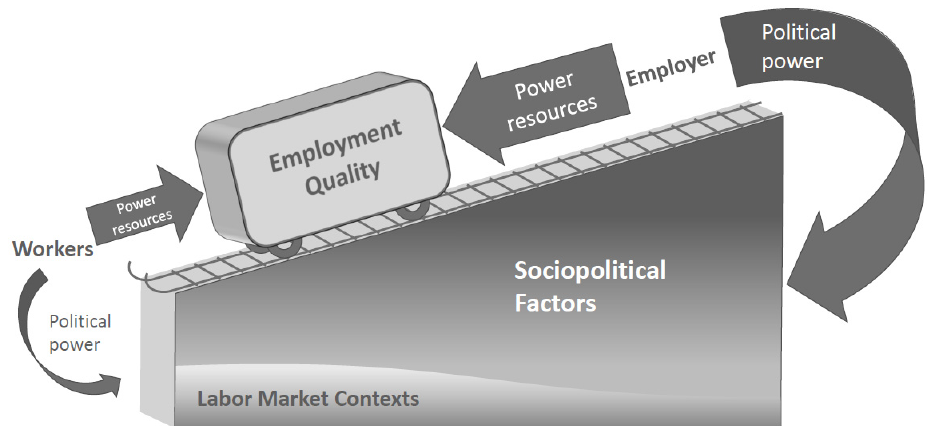
Figure 1. An allegory: Employment quality as a power balance between workers and the employer on an uneven playing field. Informed by Korpi’s Power Resource Model [14].